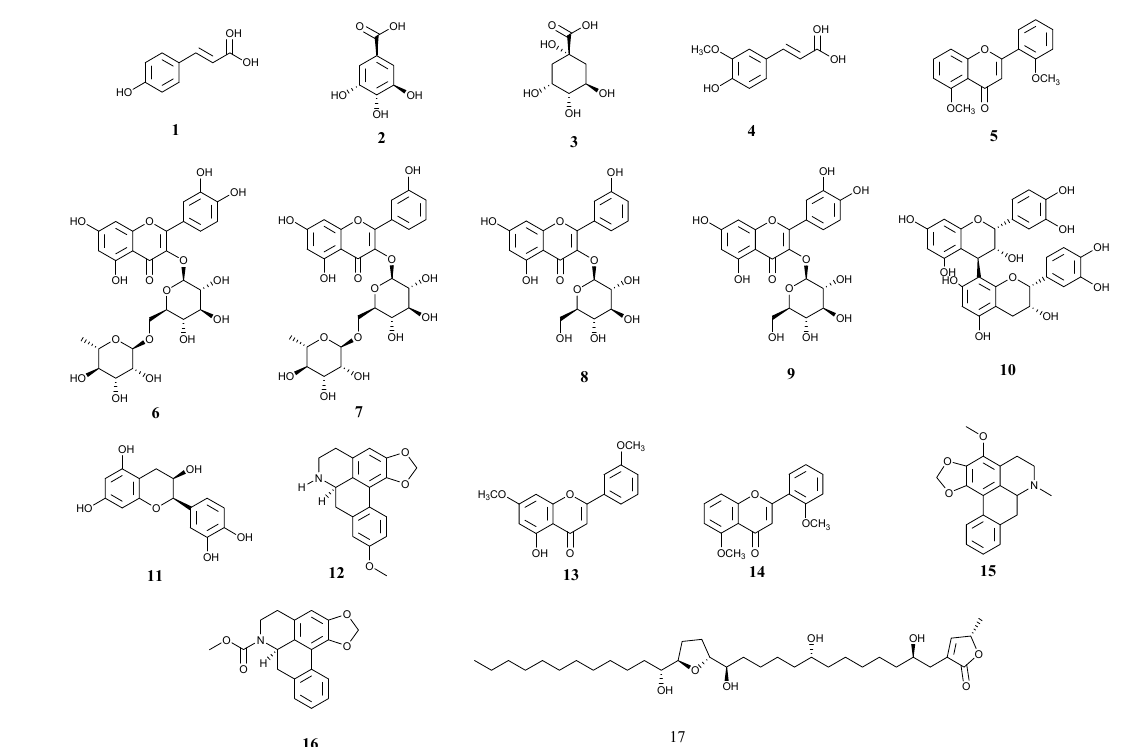
Figure 1. Constituents identified in the hydroethanolic and ethyl acetate extracts from fruit pulp of A. crassiflora (see Table 1).